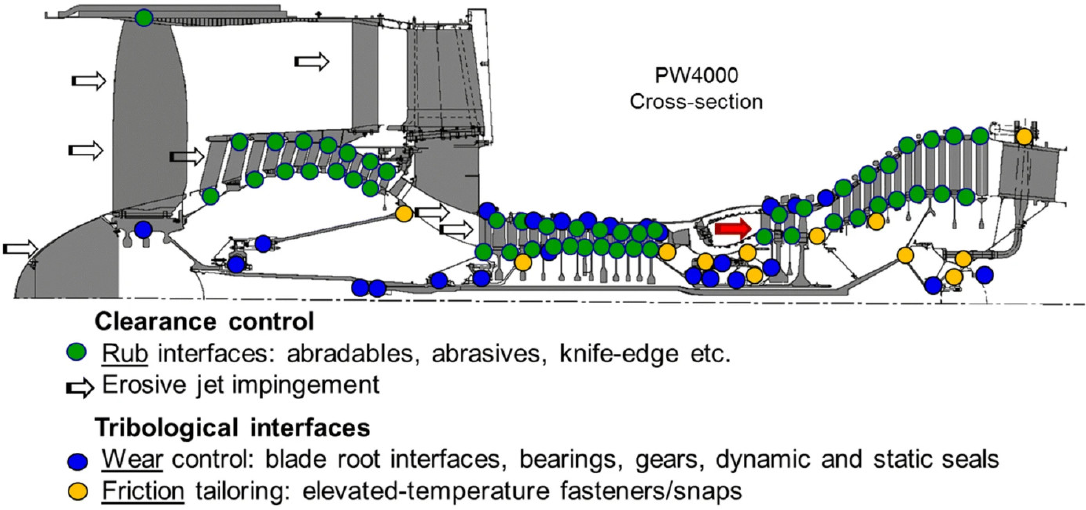
Figure 18. Typical seals and their locations in gas turbine engines [118].